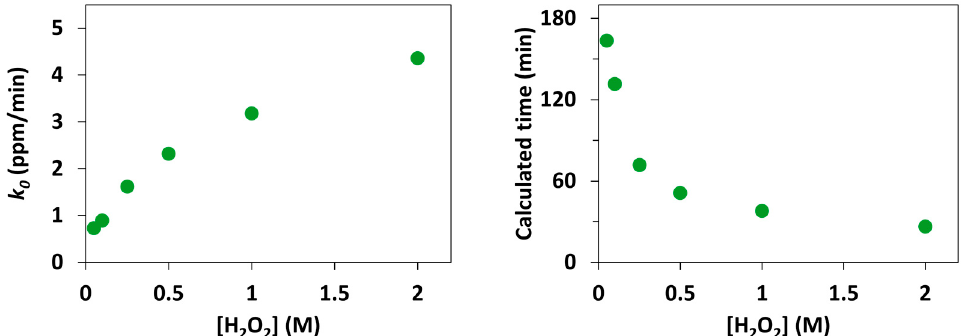
Figure 6. Rate constant ( left ) and calculated time ( right ) of MB degradation using different H 2 O 2 concentrations . H 2 O 2